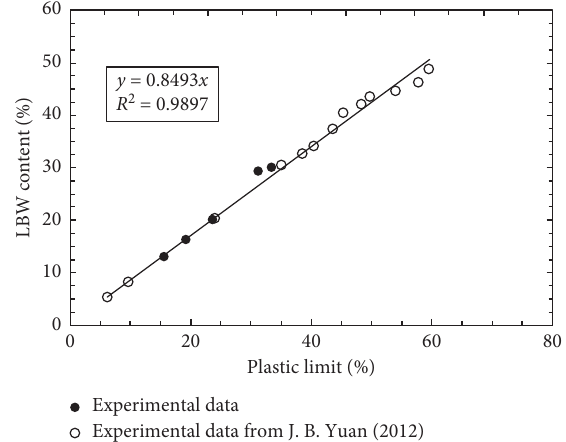
Figure 6: Fitting curve of the relationship between the LBW content and the plastic limit.